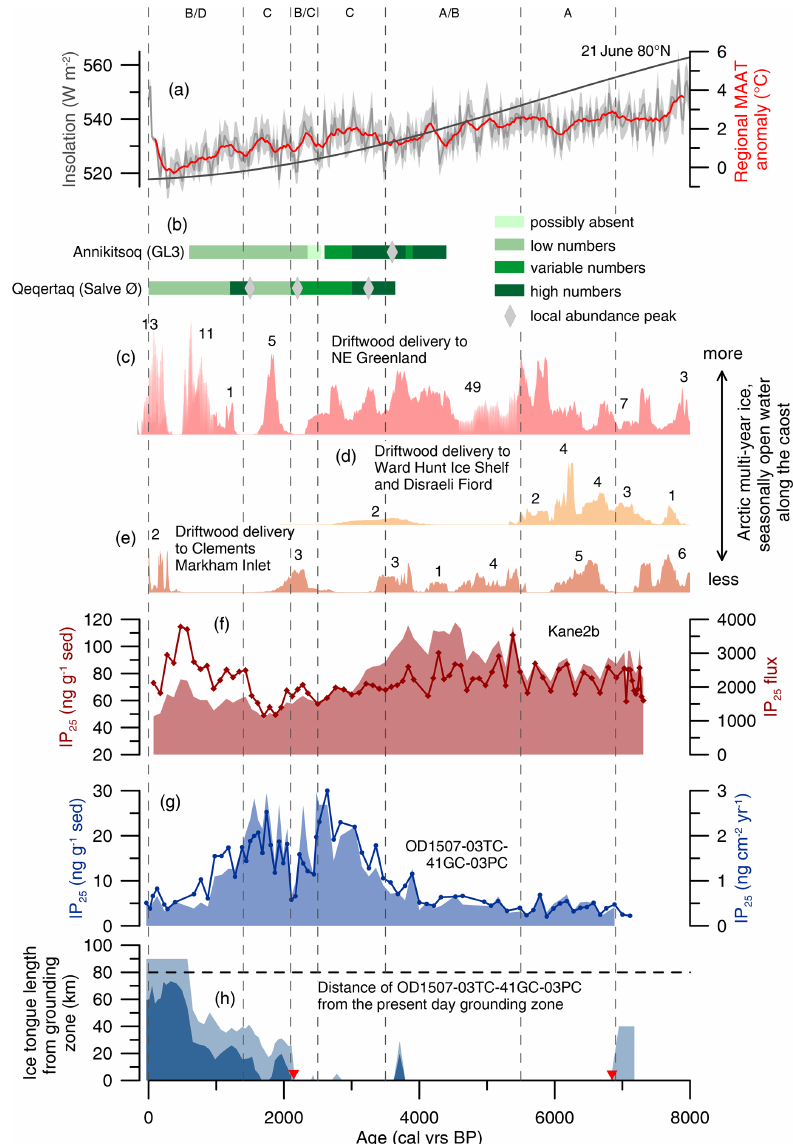
Figure 7. Holocene environmental changes in the wider Nares Strait region. From the top to the bottom: (a) regional mean annual air temperature (MAAT) anomaly based on δ 18 O at Agassiz ice cap at 25-year resolution (Lecavalier et al., 2017) (grey line) including a 2 σ uncertainty envelope (light grey filled-in area) and a 5pt running mean (red line), together with the 21 June insolation at 80 ◦ N (dark grey). (b) Inferred variability in little auk numbers in seabird colonies at Annikitsoq and Qeqertaq (Davidson et al., 2018). (c) Cumulative probability distribution of calibrated 14 C ages of driftwood in NE Greenland north of 80 ◦ N (pink filled-in area) (Funder et al., 2011). The numbers above the shaded area indicate the number of ages contributing to each block. (d) Cumulative probability distribution of calibrated 14 C ages of driftwood at Ward Hunt Ice Shelf and in Disraeli Fiord (yellow filled-in area) (England et al., 2008). The numbers above the shaded area indicate the number of ages contributing to each block. (e) Cumulative probability distribution of calibrated 14 C ages of driftwood in Clements Markham Inlet (yellow filled-in area) (England et al., 2008). The numbers above the shaded area indicate the number of ages contributing to each block. (f) IP 25 fluxes (red, filled-in area) and absolute concentrations (red line with diamonds) normalized to the amount of sediment extracted at AMD14-Kane2b (Georgiadis et al., 2020). (g) IP 25 fluxes (blue, filled-in area) and absolute concentrations (blue line with dots) normalized to the amount of sediment extracted at OD1507-03TC-41GC-03PC. (h) Reconstruction of the Holocene ice tongue extent (minimum extent in dark blue, maximum extent in light blue) in Petermann Fjord in kilometers from the grounding zone (Reilly et al., 2019). OD1507-03TC-41GC-03PC is located 80km from the present-day grounding zone (black dashed line). Corresponding to Fig. 6, interpretations of past ice arch dynamics in Nares Strait are marked with dashed vertical lines. The letters at the top correspond to the schematic scenarios in Fig. 6. The red triangles on the x axes indicate the timing of the ice tongue breakup ( ∼ 6900calyrBP) and the late Holocene inception of a small ice tongue ( ∼ 2200calyrBP) (Reilly et al., 2019). The Cryosphere, 15, 4357–4380, 2021